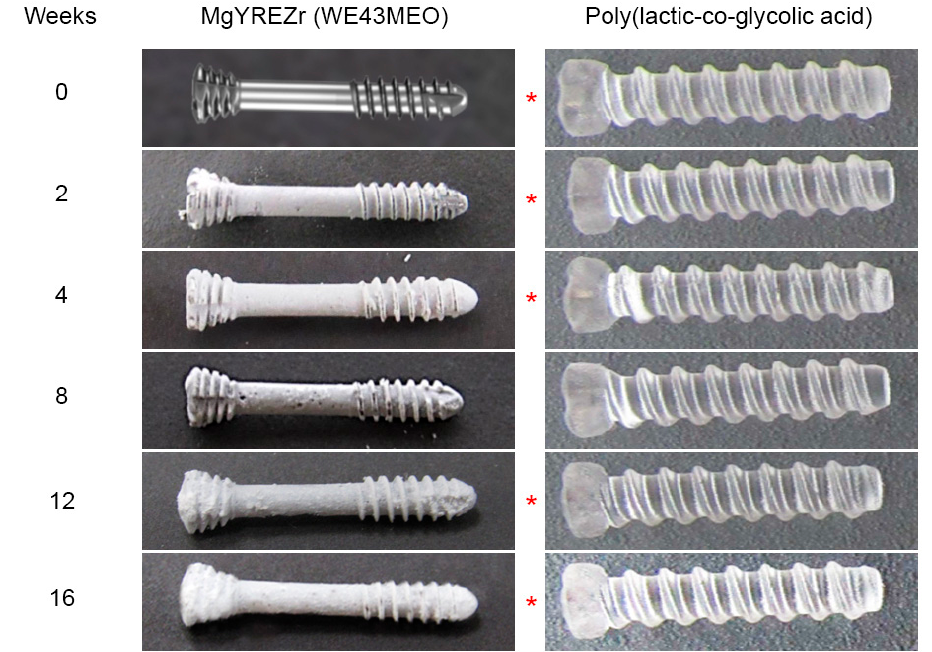
Figure 1. Appearance of samples used in the resorption experiment: magnesium alloy screws on the left-hand and poly(lactic-co-glycolic acid) screw on the right-hand side. All screws had a length of 14 mm. Their length did not change during the experiment. The photographs were not scaled; hence the different lengths in the picture. Asterisks indicate statistical significance in the pull-out